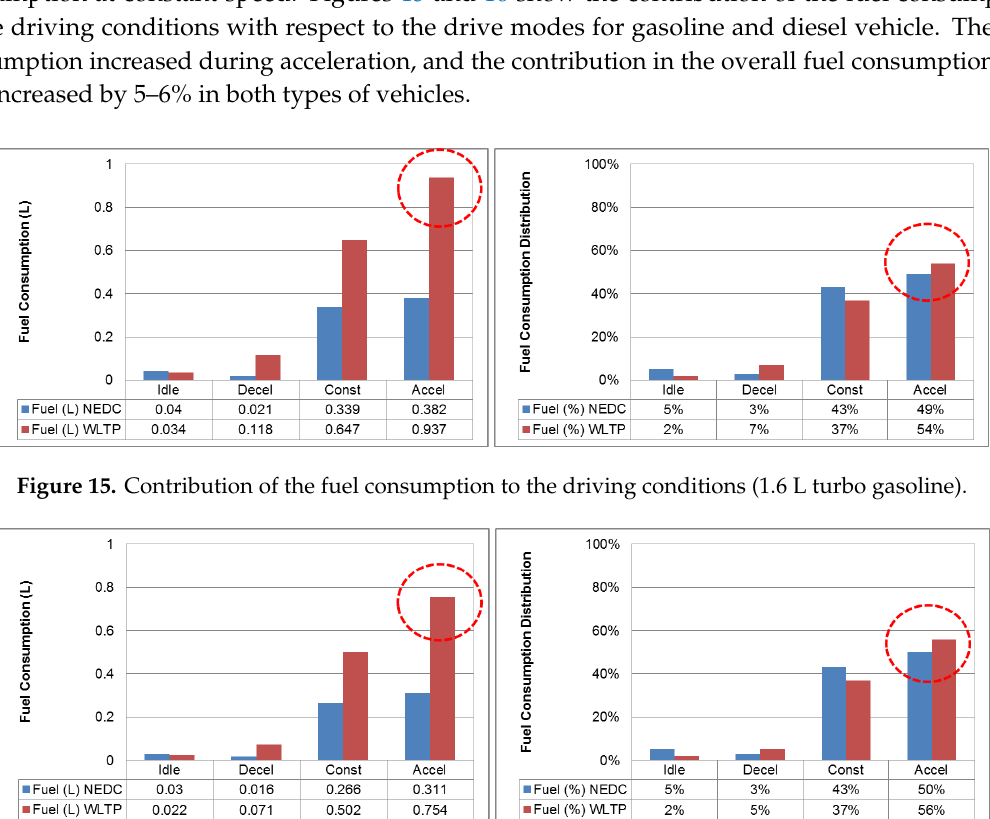
Table 7. Determination of the test mass.